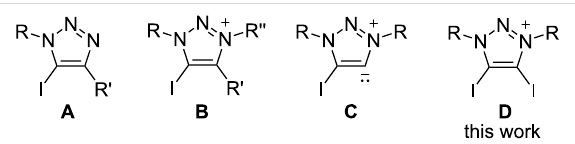
Figure 1: 1,2,3-Triazole based XB donors: 1,2,3-triazole A , 1,2,3-tri- azolium B , 1,2,3-triazolylidene C and diiodotriazolium D